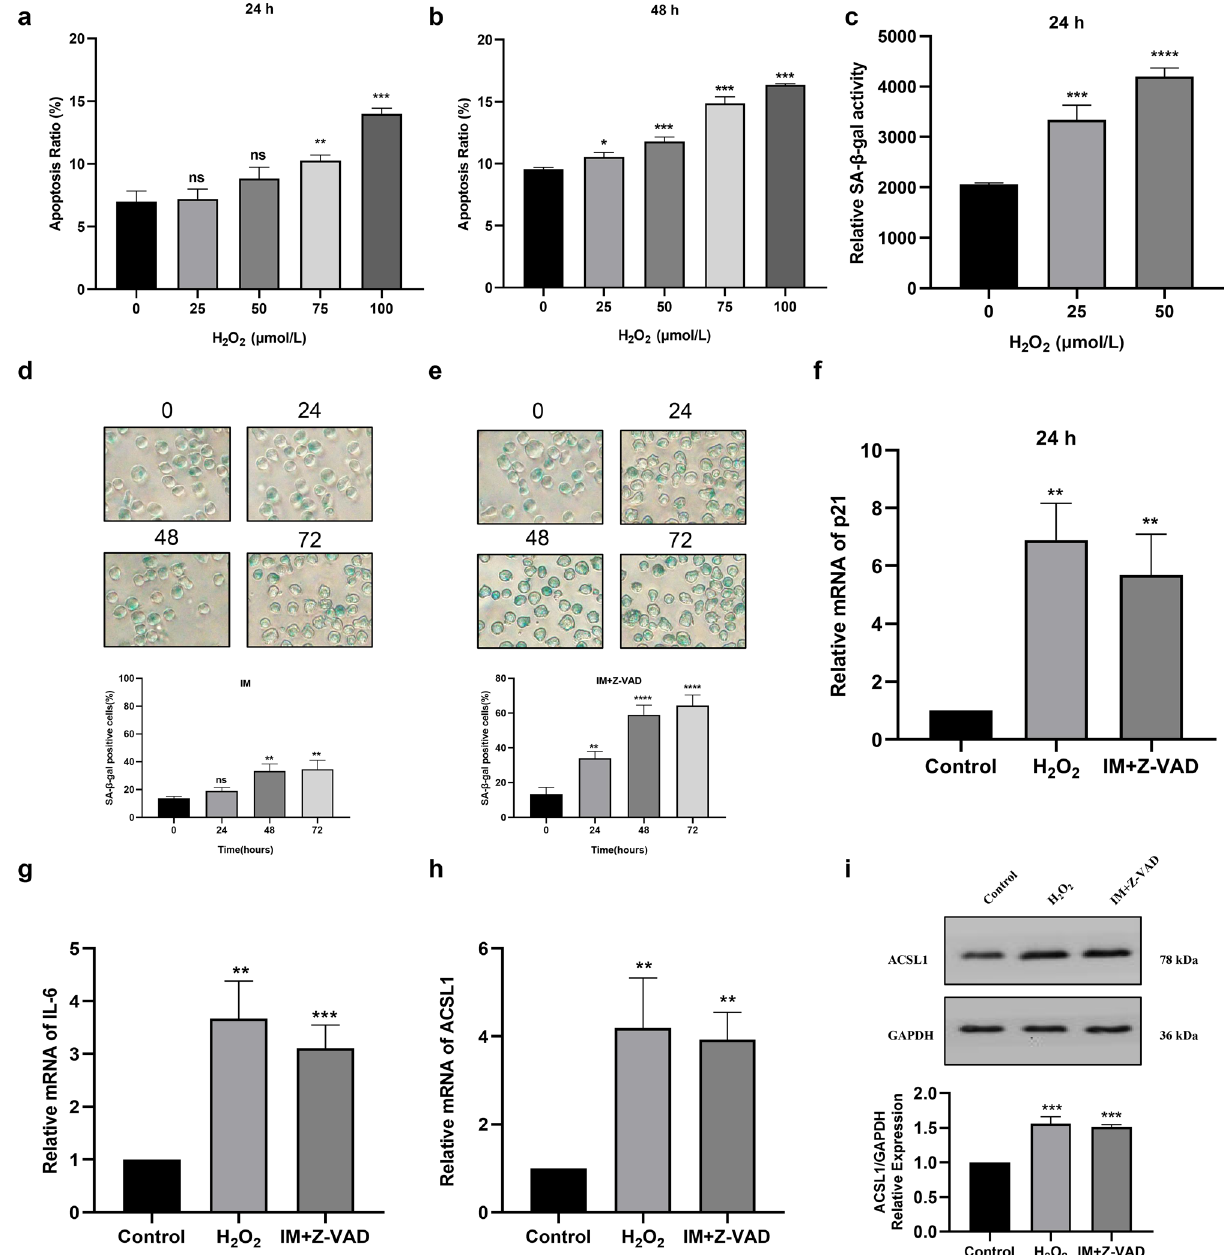
Figure 1. ACSL1 is up-regulated in senescent K562 cells. ( a – c ) Apoptosis and the mean fluorescence intensity (MFI) of SPiDER-β Gal were measured by flow cytometry to determine the optimal concentration and treatment time of H 2 O 2 in K562 cell line. ( d , e ) Cell senescence assay by SA-β-gal staining was applied to determine the optimal treatment time of imatinib plus Z-VAD in K562 cell line. ( f , g ) qRT-PCR was applied to quantify the relative expression of senescence-associated genes p21 and IL-6. ( h , i ) qRT-PCR and western blot analysis were applied to quantify the relative mRNA and protein expression of ACSL1. ns not significant, *p < 0.05, **p < 0.01 and ****p <